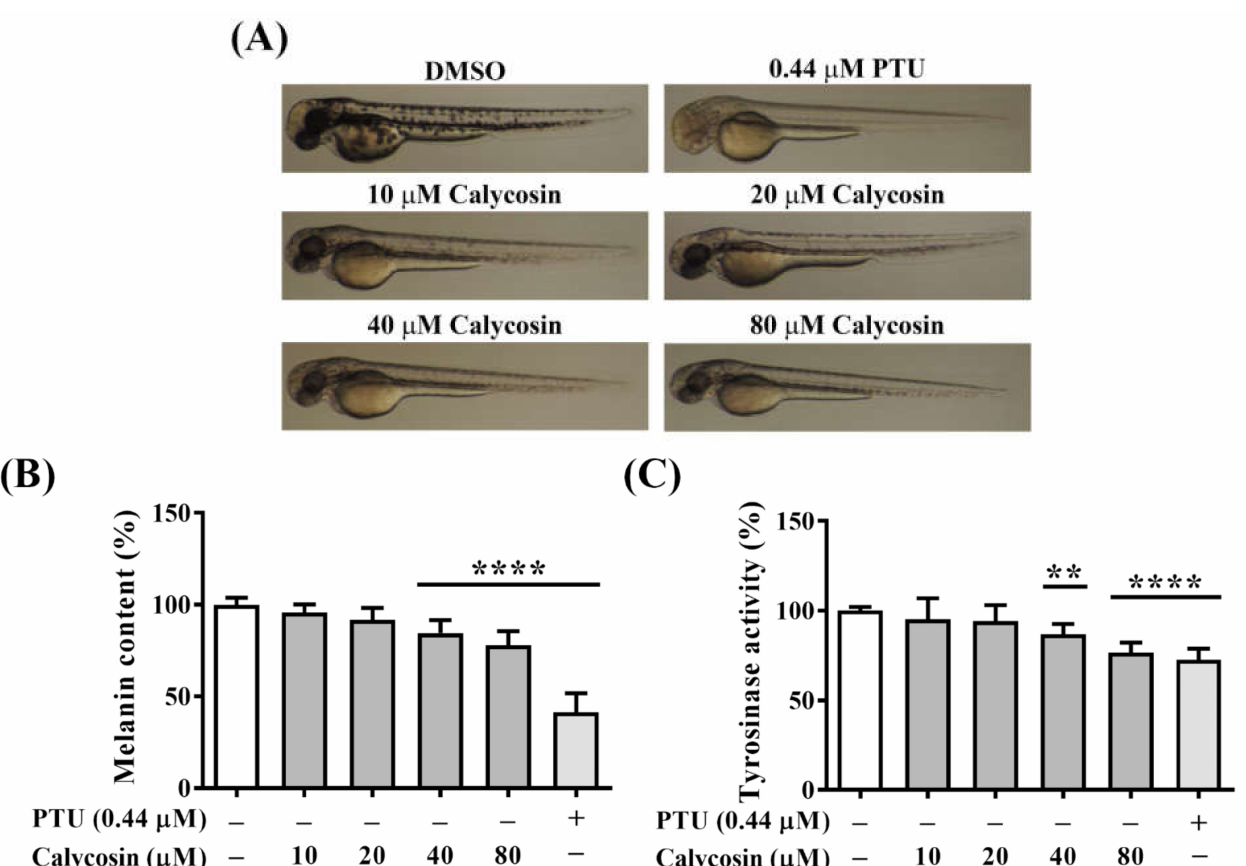
Figure 6. The inhibitory effect of calycosin on zebrafish pigmentation. ( A ) Representative images of melanin distribution in zebrafishes treated with indicated concentrations of calycosin. Positive control: 0.44 µ M phenylthiourea (PTU). ( B ) Effects of calycosin on ( B ) melanin content (%) and ( C ) tyrosinase activity (%) in zebrafishes treated with indicated concentrations of calycosin. Data are represented as the means ± S.D. from three independent experiments. Significant difference versus DMSO control: ** p < 0.01, **** p <